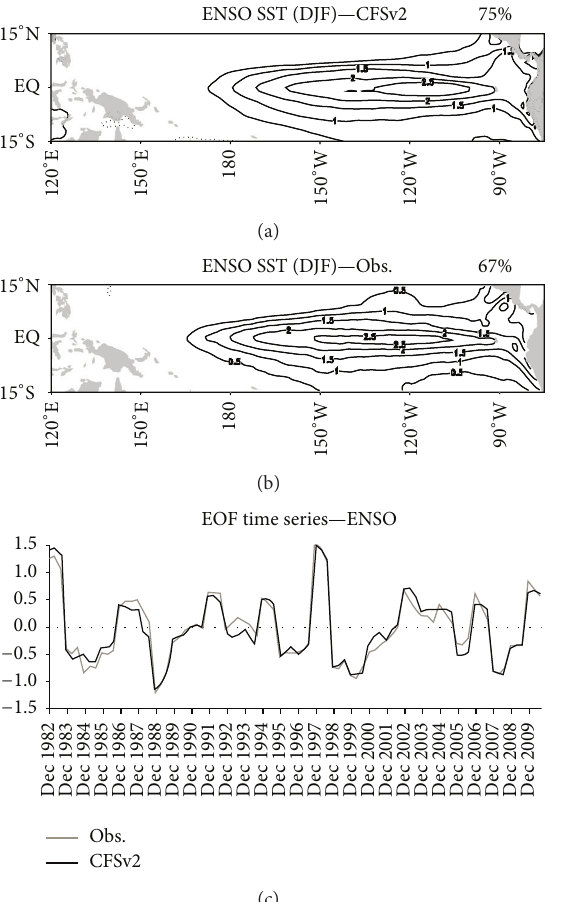
Figure 10: El Ni˜no-Southern Oscillation (ENSO) pattern captured from anomalous SST over 15 ∘ N–15 ∘ S and 120 ∘ –285 ∘ E during DJF at 0-month lead for (a) CFSv2; (b) Optimum Interpolation v2 SST (Obs.); (c) thecorresponding EOF timeseries which the gray (black) lineisrelatedtoObs.(CFSv2).Contourintervalis0.5 ∘ Candnegative contours are dotted.